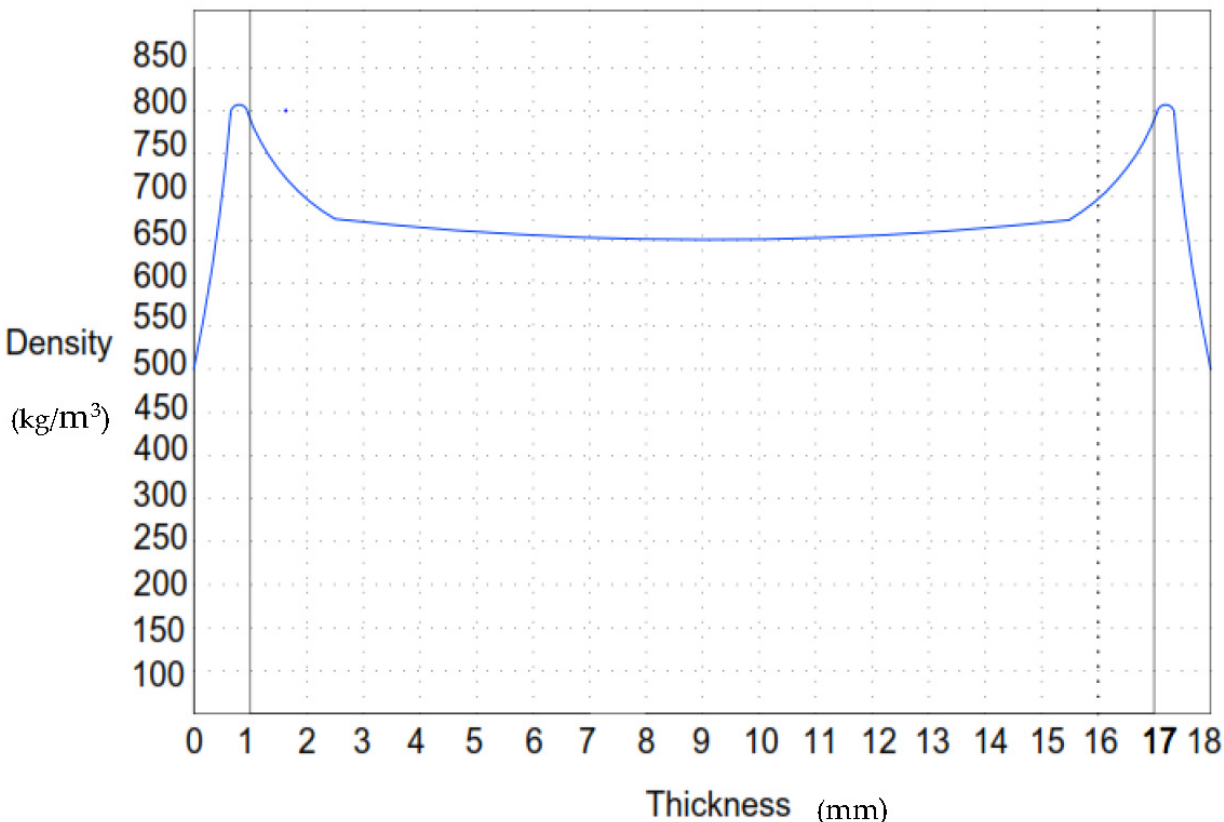
Table 10. Internal bonding test results.